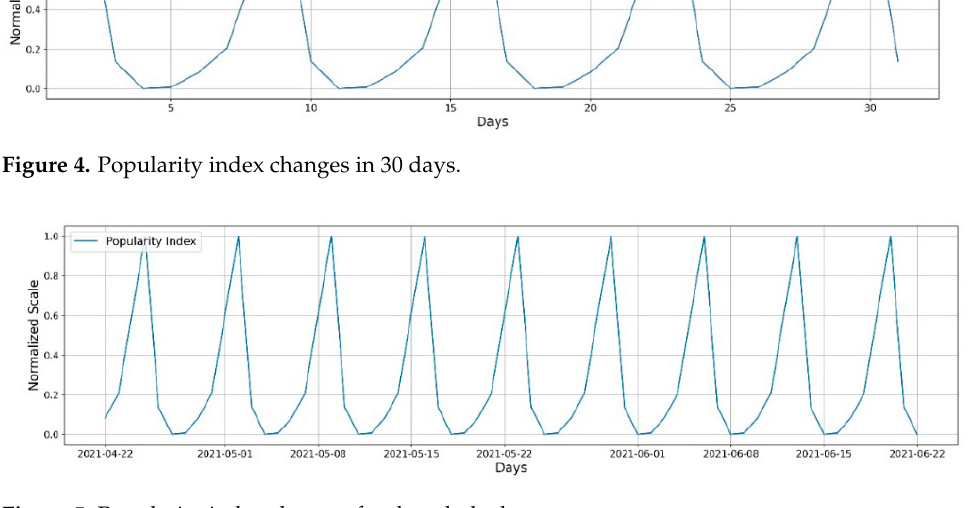
Figure 5. Popularity index changes for the whole dataset.